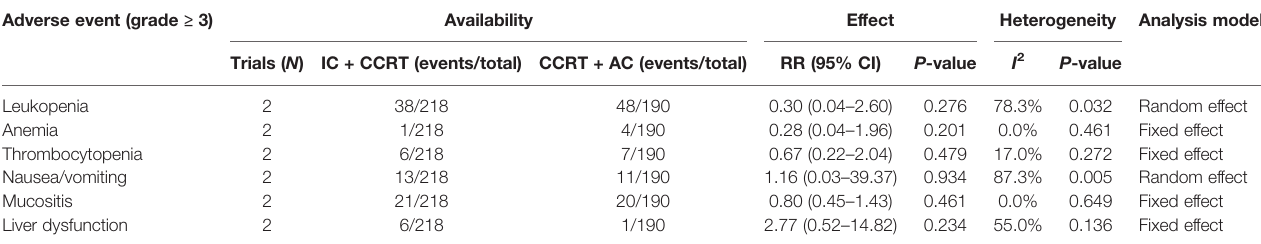
TABLE 5 | Severe toxicity during the IC + CCRT and CCRT + AC in meta-analysis. Adverse event (grade ≥ 3)